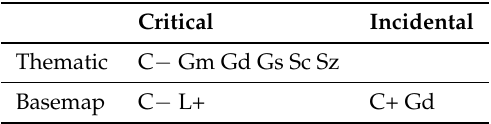
Figure 2. Charles Minard’s 1869 map of Napoleon’s march on Moscow in 1812, a thematic flow map depicting the heavy human losses Napoleon’s army suffered using an ever-thinning line. The beige and black areas represent the size of Napoleon’s army through time, with the graphic variable of size (i.e., line width) reflecting counts of soldiers; the beige line progresses eastward for the advancement of the army, the black line regresses westward for its retreat. Table 3. Schedule of operators for Minard’s map of Napoleon’s